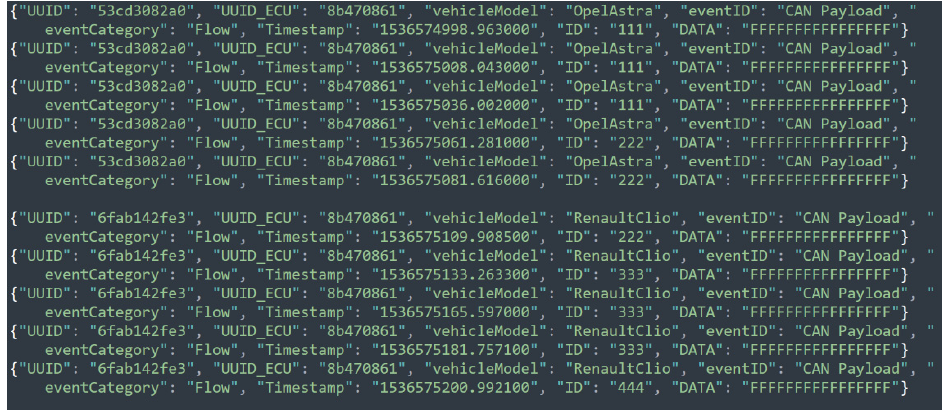
Figure 14. The JSON messages created to test the Fuzzing rule.